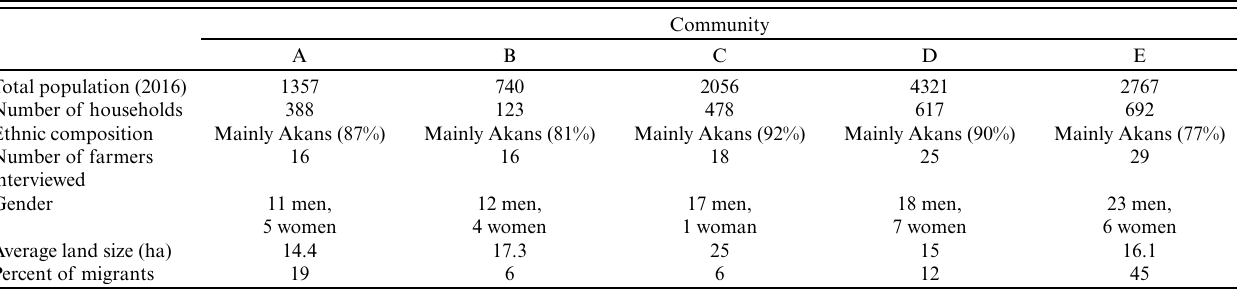
Table 1 . Profile of the study communities. Data sources: Ghana Statistical Service (2013), field notes (2016), District Medium Term Development Plans (2012-2016).